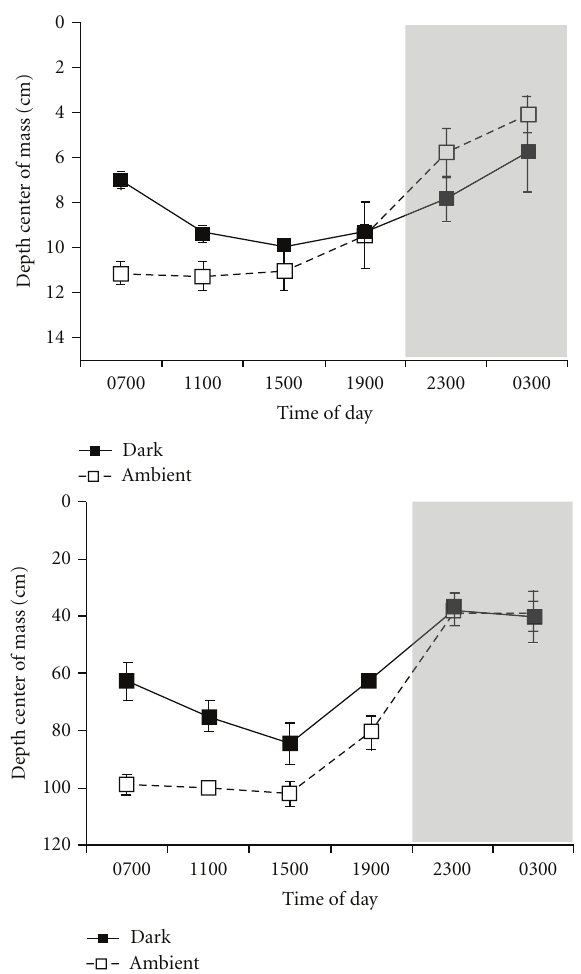
Figure 2: Depth center of mass for Kelletia kelletii larvae through- out a 24hr period in 9.5d × 15hcm columns (“short,” top panel) and 9.5 d × 125 hcm columns (“tall,” bottom panel) in treatments ( n = 4) of ambient photoperiod (16:8h, open squares) or dark only (0:24 h, black squares). Grey shading indicates lights o ff in the ambient photoperiod. Error bars represent ± 1 SE.